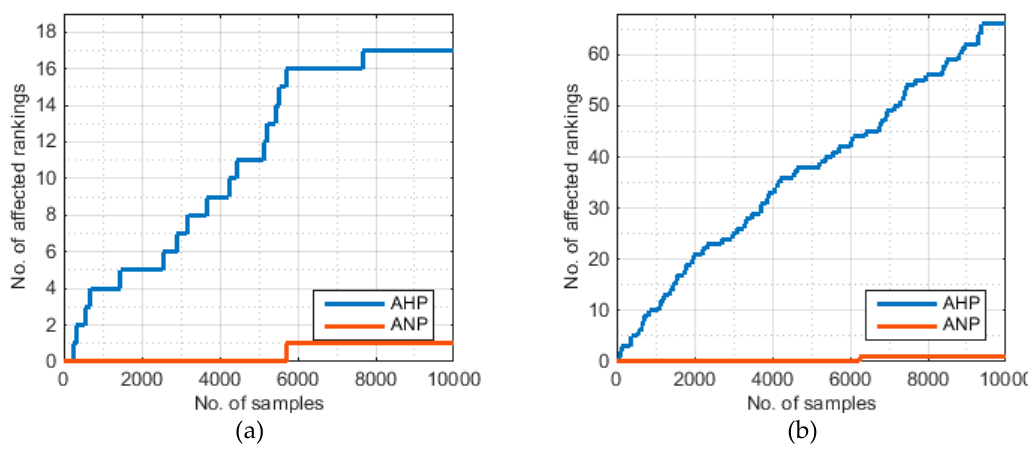
Figure 5. The number of changed rankings for the alternative A5 generated: (a) without considering dependencies between sub-criteria; (b) when taking into account dependencies between sub-criteria